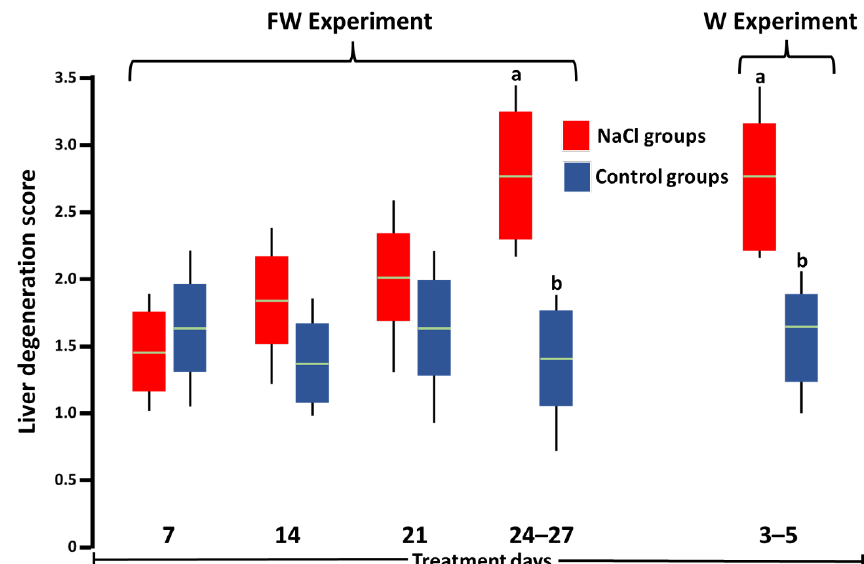
Figure 4. Score of the percentage of degenerated hepatocytes of SPF Leghorn chickens at 27 days of treatment with 3.3% NaCl in feed and 5 days with 1% NaCl in drinking water (FW experiment) or at 5 days of treatment with 1% NaCl in drinking water (W experiment). Different letters above boxes for the same experiment denote significant differences ( p < 0.05). Green line: median. Table 2. Differential leukocyte count of SPF Leghorn birds at 27 days of treatment (td) with 3.3% NaCl in feed and 7 days with 1% NaCl in drinking water (FW